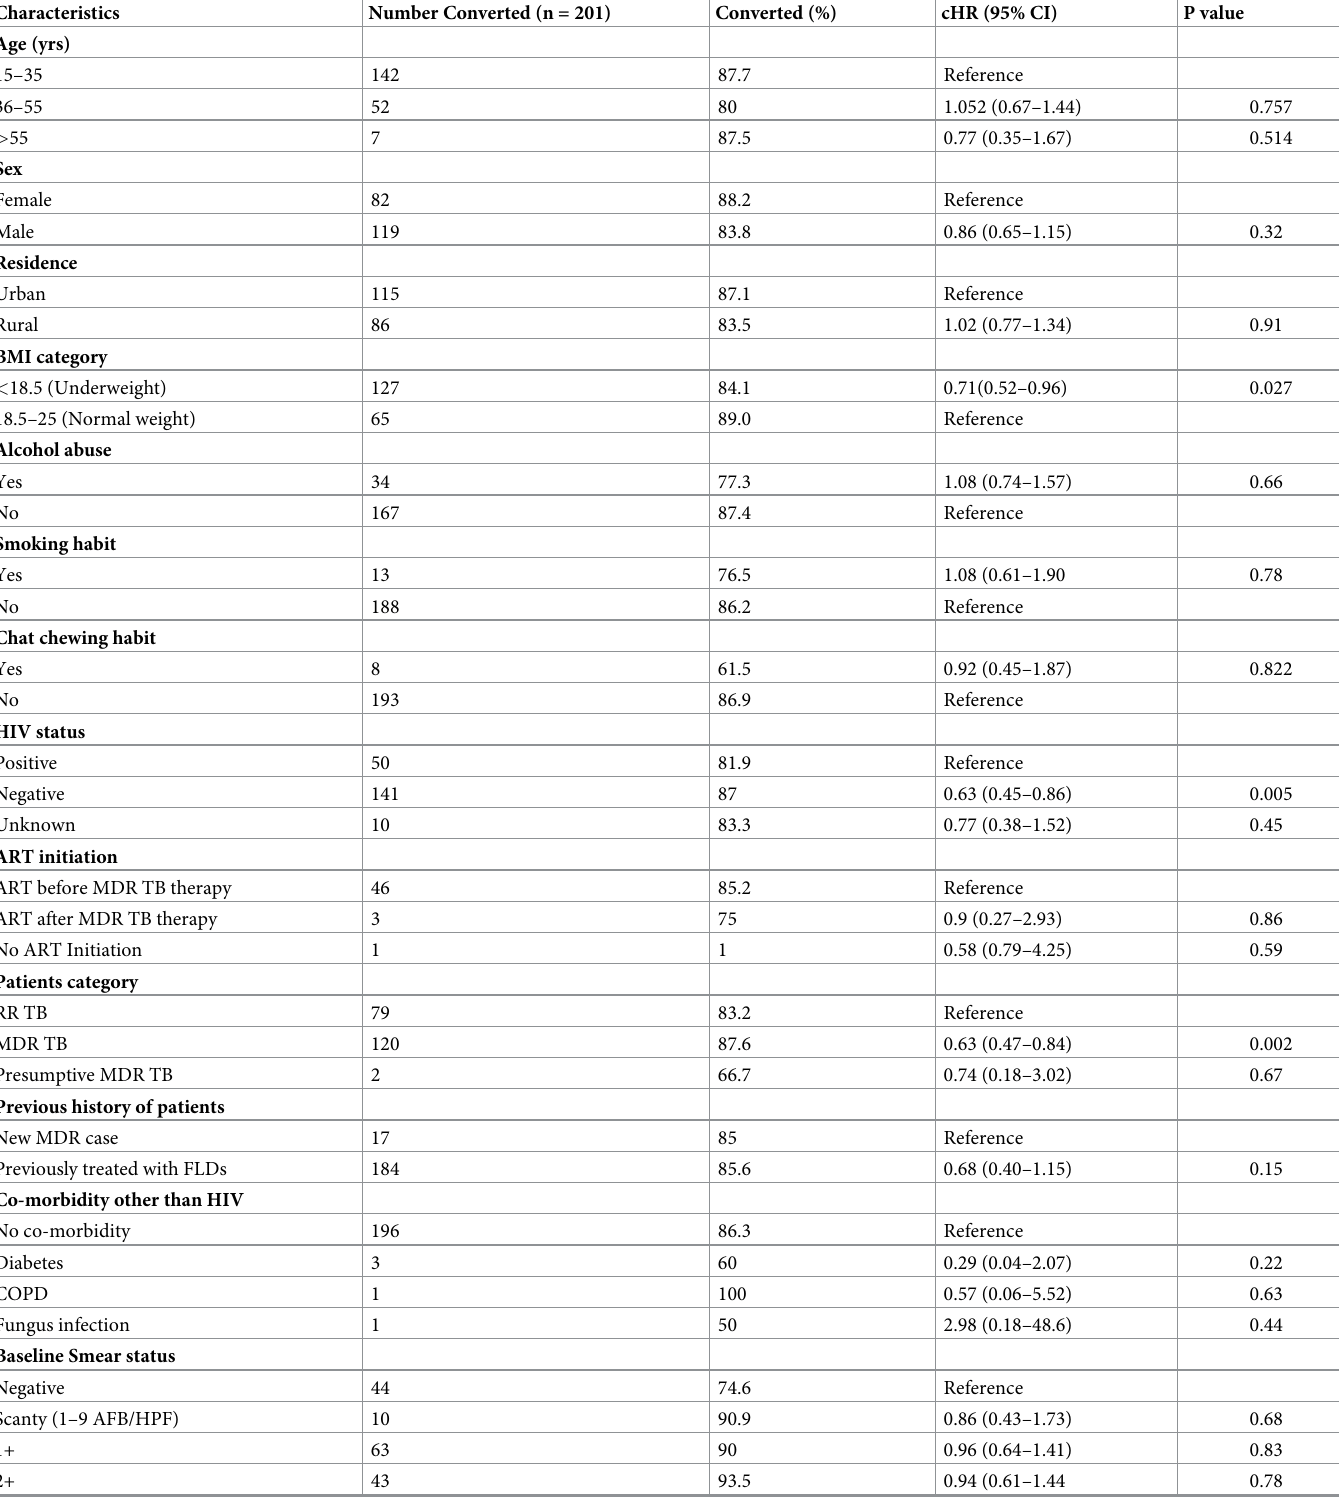
Table 2. Univariate analysis of predictors of initial sputum culture conversion among multi-drug resistant tuberculosis patients (cid:3) .